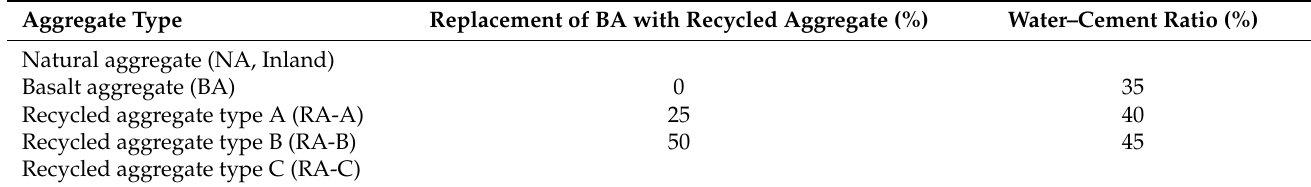
Table 1. Experimental parameters.